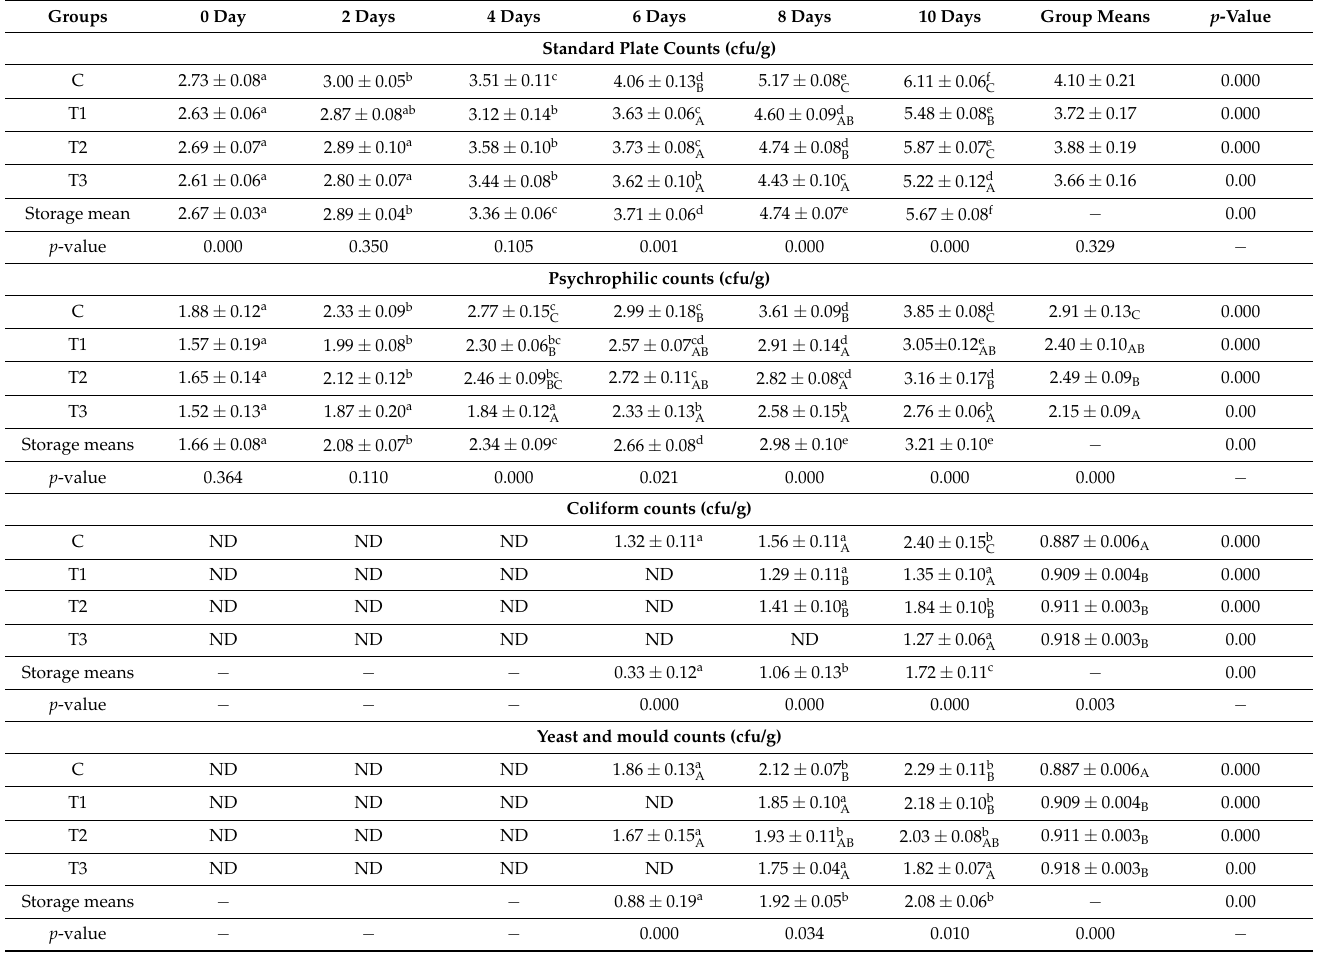
Table 3. Effect of turmeric and aloe vera extracts on the microbial quality of goat and buffalo paneer during refrigerated aerobic